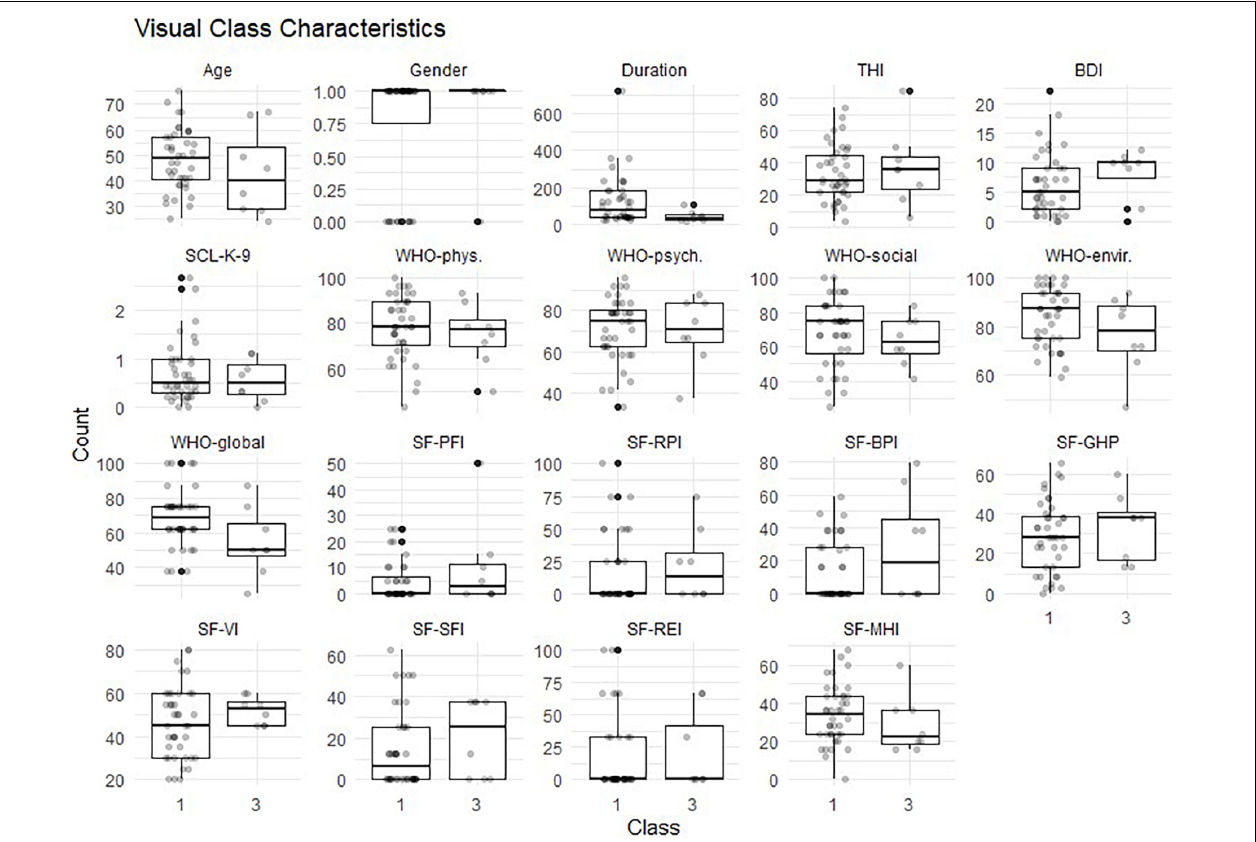
FIGURE 5 | Characteristics of non-responder (class 1) vs. responder (class 3). Sex (male = 1; female = 0); THI, Tinnitus Handicap Inventory; BDI, Beck Depression Inventory; SCL-K-9, Symptom Checklist; WHO, World Health Organization Quality of Life Questionnaire with 4 subscales: phys, physiological, psych, psychological; social, envir; environmental; SF-36, Short Form Health Questionnaire with 8 subscales; PFI, Physical Functioning Index; RPI, Role-Physical Index; BPI, Bodily Pain Index; GHP, General Health Perceptions Index; VI, Vitality Index; SFI, Social Functioning Index; REI, Role-Emotional Index; MHI, Mental Health